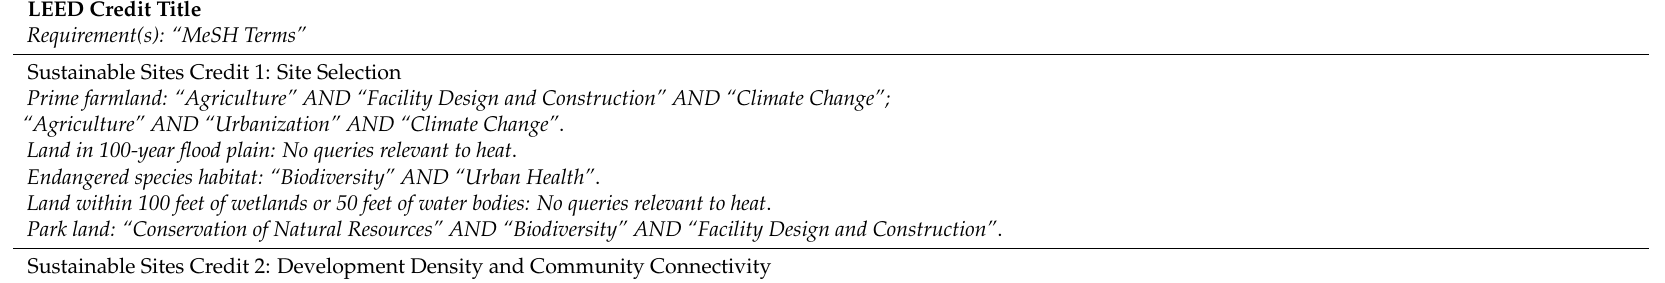
Table A2. MeSH Terms queried by LEED